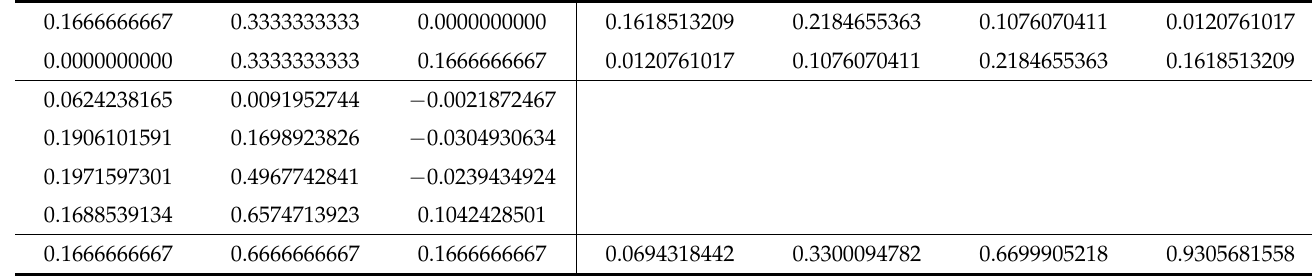
Table A29. eL3|G4 method.